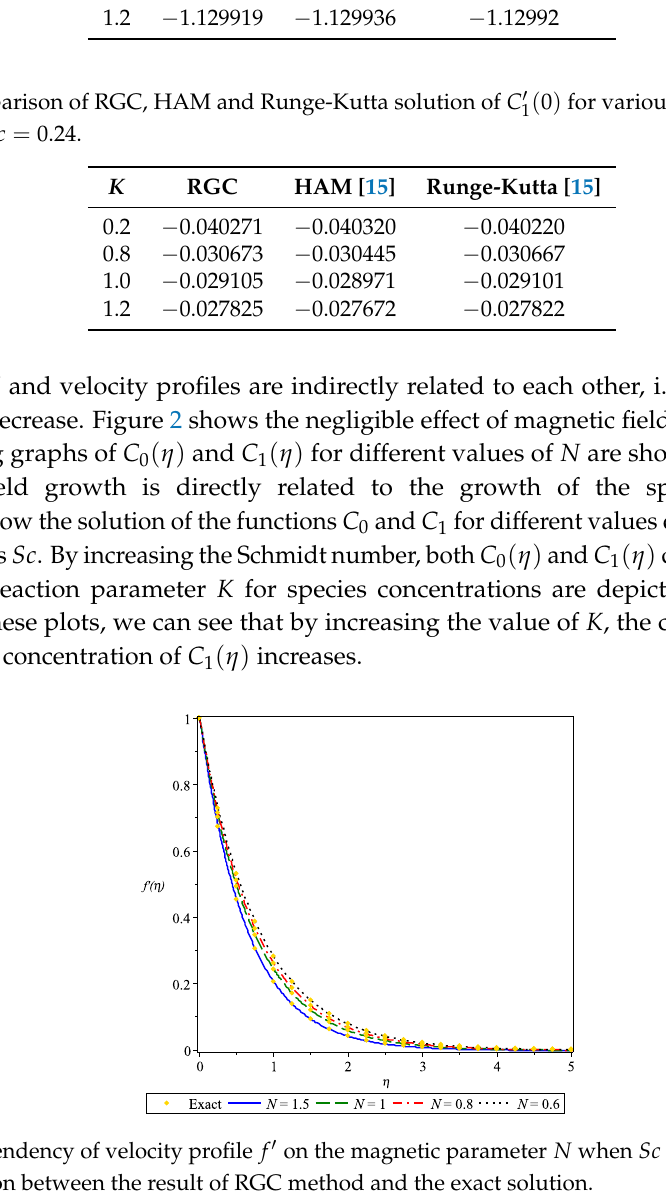
( 0 ) for various values of K while 0